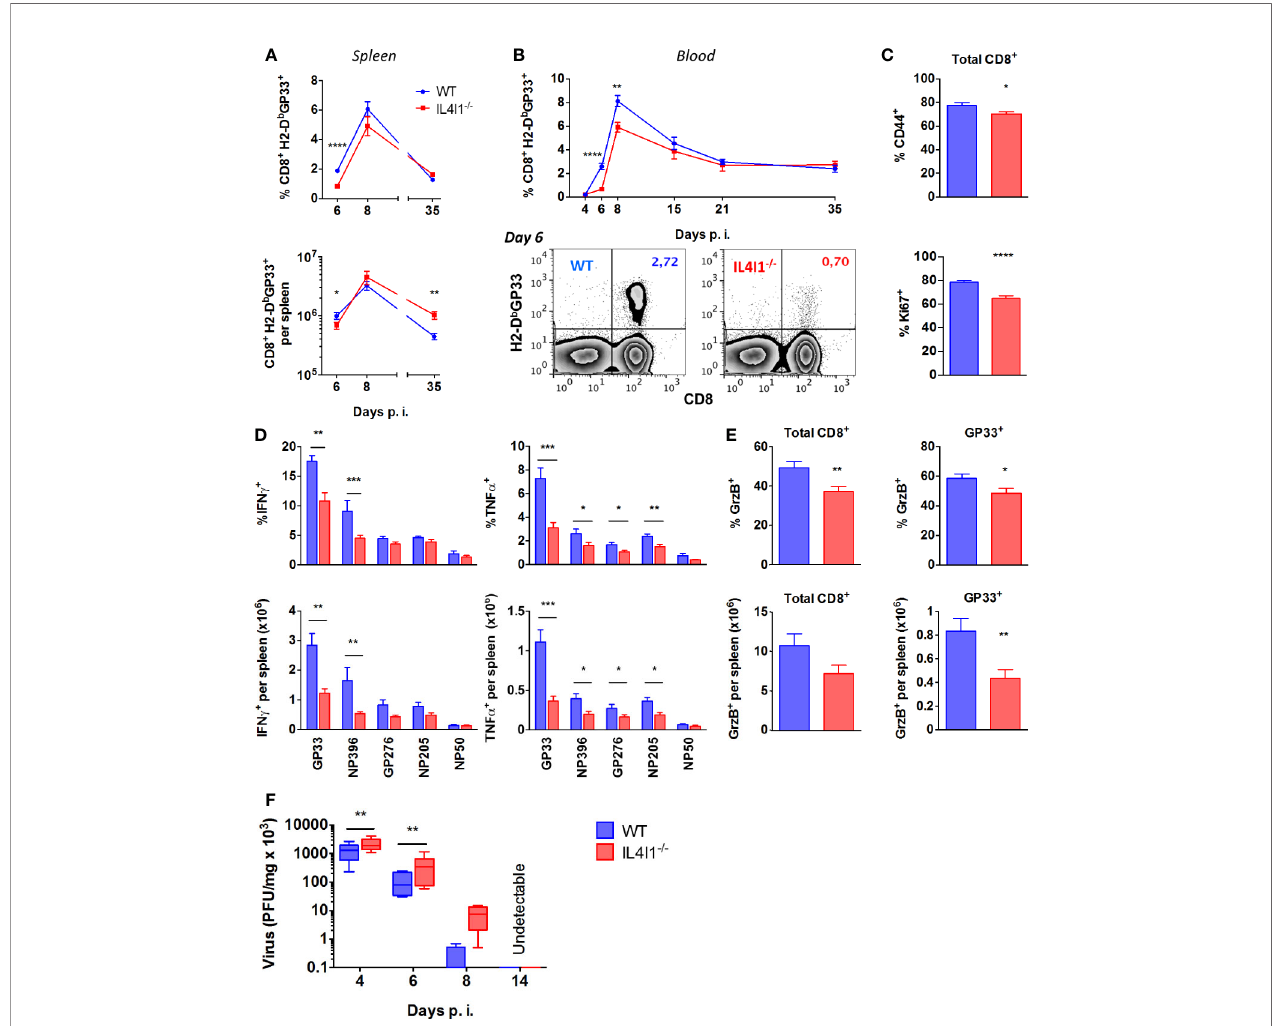
FIGURE 1 | Reduced number of functional effector CD8 T cells in LCMV-infected IL4I1 -/- mice. WT (blue) and IL4I1 -/- (red) mice were infected i.v. with LCMV on day 0 (A, B) . The post-infection (p.i.) percentage of GP33-speci fi c CD8 T cells among viable lymphocytes was measured in the spleen ( A , upper graph) and blood (B) by fl ow cytometry using H2-D b GP33 tetramers. Total numbers of splenic GP33-speci fi c CD8 T cells were calculated based on viable splenocyte counts ( A , lower graph). Representative data in the blood at day 6 are shown in (B) , lower panels (C) . Expression of the activation marker CD44 (upper graph) and of the mitotic marker Ki67 (lower graph) by splenic CD8 + T lymphocytes at day 6 (D) . Intracellular IFN g and TNF a at day 6, after in vitro stimulation of splenocytes with the LCMV peptides GP33, NP396, GP376, and NP205 and control in fl uenza peptide NP50. The upper graphs show the percentage of CD44 + CD8 + T cells and the lower graphs the calculated total number in the spleen (E) . Intracellular granzyme B (GzB) at day 6. The upper graphs show the percentage of total and GP33-speci fi c CD44 + CD8 + T cells and the lower graphs the calculated total number in the spleen (A – E) . The means ± SEM from three to four independent experiments with three to four mice per group are shown (F) . Viral titers were measured in the spleen (PFU, plaque-forming units). Mean ± SEM from two (day 14) to 11 (day 4) independent experiments with one to two mice per group. * p < 0.05, ** p < 0.005, *** p < 0.001; **** p < 0.0001 (Student t test: A – E ; Wilcoxon paired t test: F